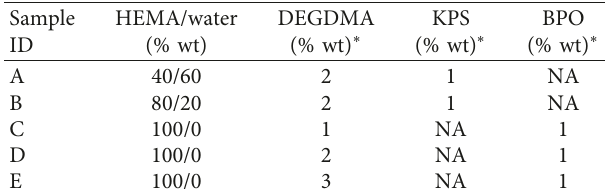
NA: not added; ∗ relative to monomer HEMA